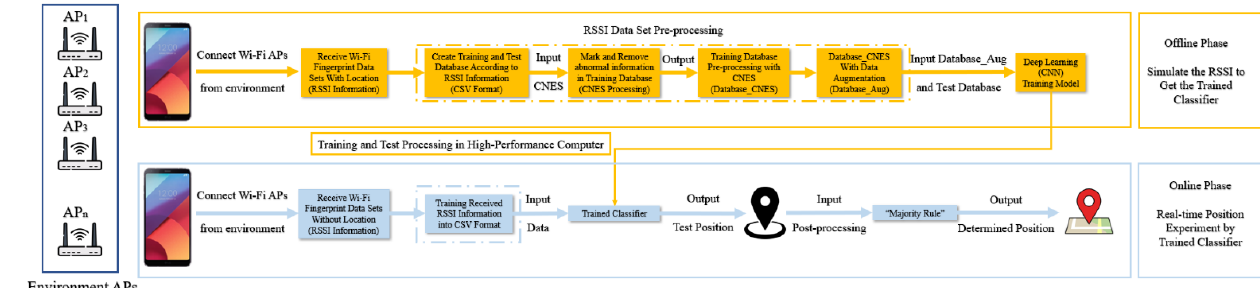
Figure 1. Fingerprint positioning with a deep learning classifier from [15].